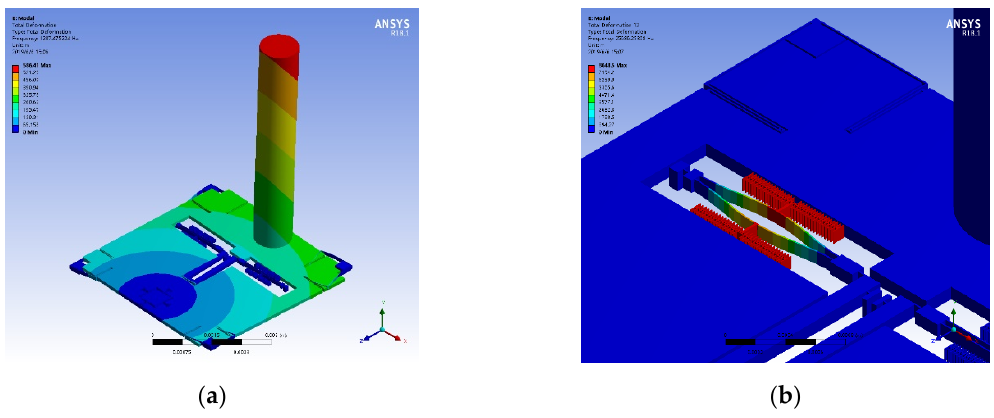
Figure 4. Simulation modes of bionic hair sensor with resonant readout. ( a ) Sensitive mode; ( b ) Anti-phase resonant mode of the resonator.